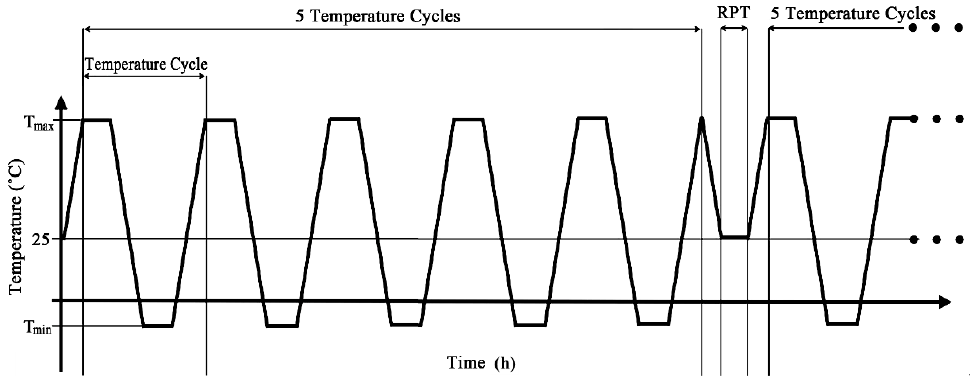
Figure 4. Timing diagram of reference power test (RPT).